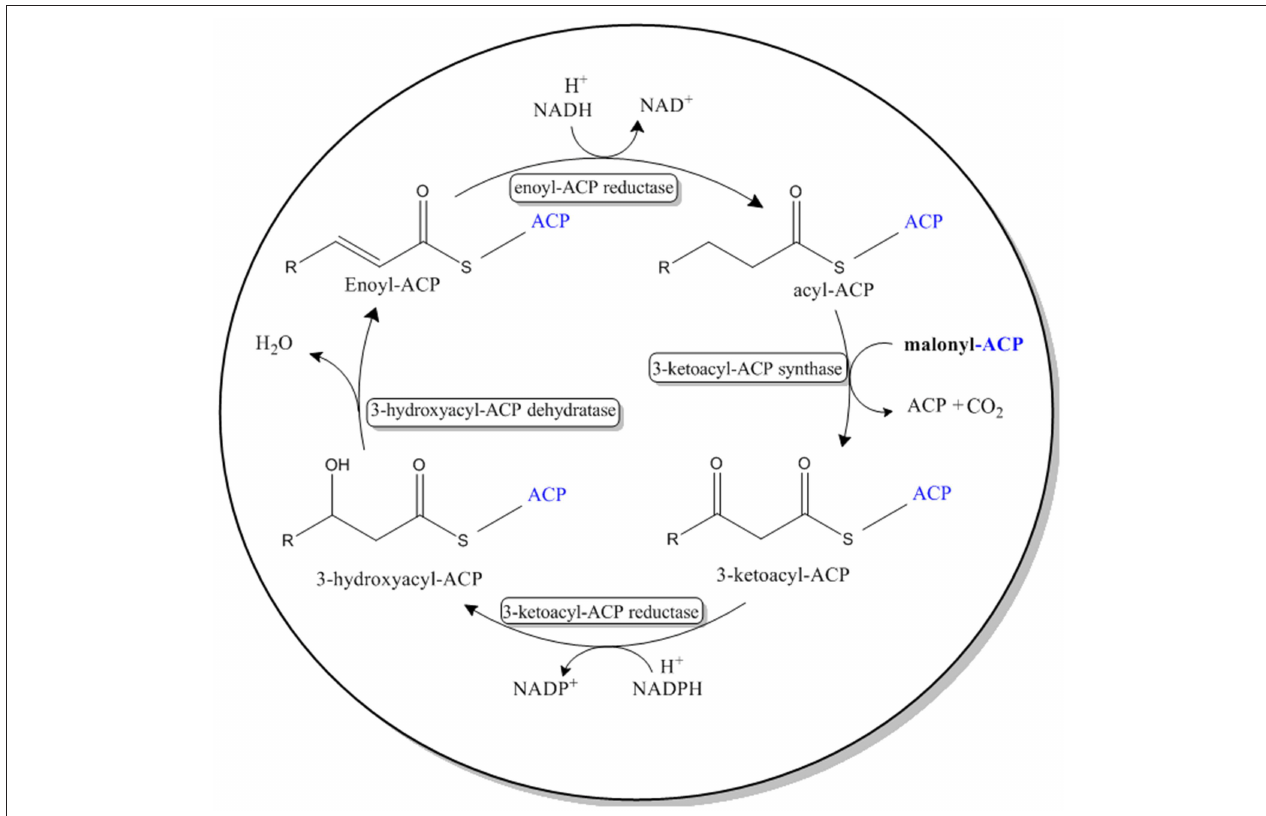
FIGURE 2 | Pathway for the de novo biosynthesis of fatty acids in most prokaryotes and eukaryotes. This system can be found in the chloroplast of A. thaliana and the cytoplasm of E. coli . Malonyl-ACP is used as the 2-Carbon elongation